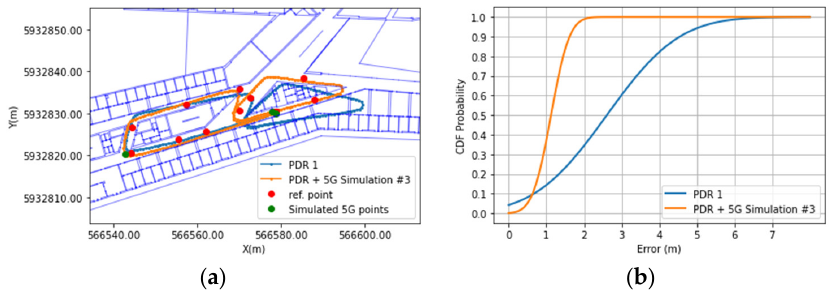
Figure 10. The proof of concept in fusion of 5G and PDR using three simulated points: ( a ) Trajectories; and ( b ) Error vs. CDF probability of mentioned methods.